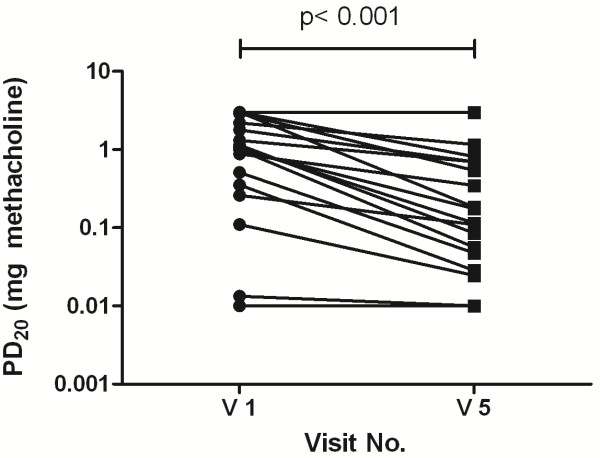
The PD20FEV1methacholine on a logarithmic scale before and after the bronchial allergen challenges. The PD20FEV1 decreased significantly from1.30 mg ± 1.08 to 0.45 mg ± 0.72 (p < 0.001).